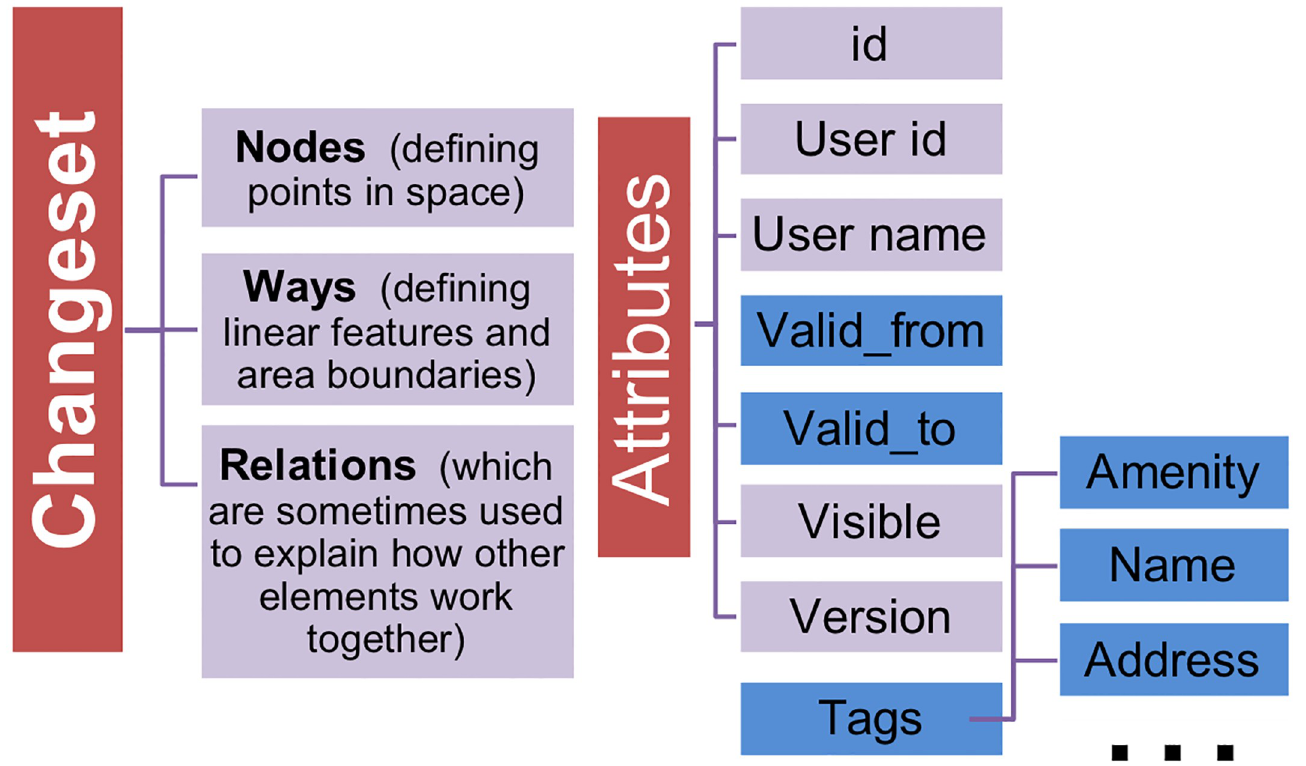
Fig 1. OSM‘s changeset data object